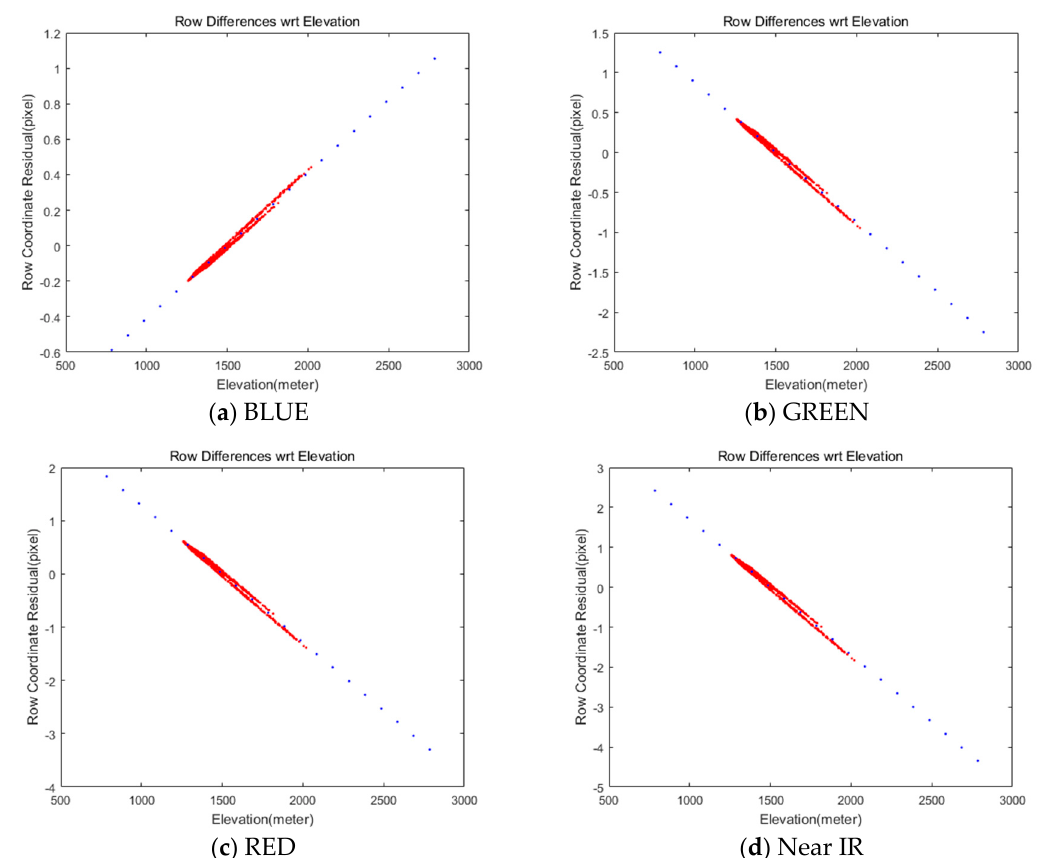
Figure 10. Relationship between row coordinate differences between MS and PAN images due to ground terrain elevation changes (red: row coordinate mismatches, blue: coordinates’ compensation).